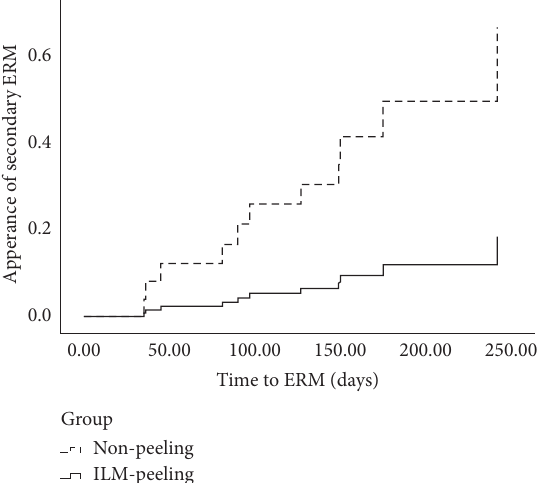
Figure 4: Cox proportional curves on the basis of ILM peeling. ILM, internal limiting membrane; ERM, epiretinal